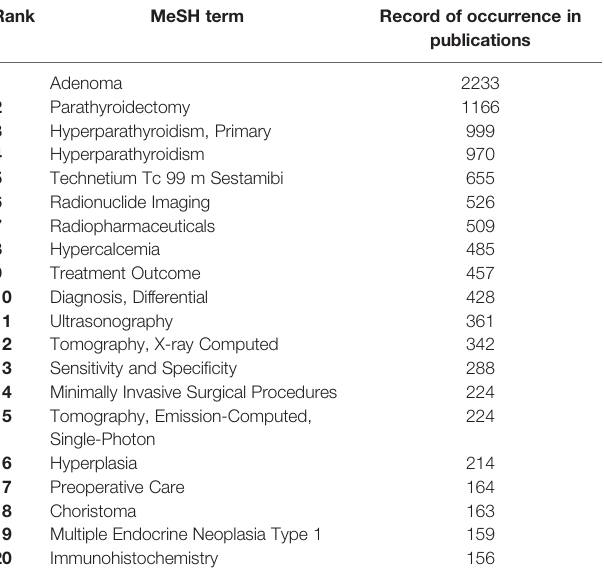
TABLE 1 | Overall ranking of research foci in the past 22 years.